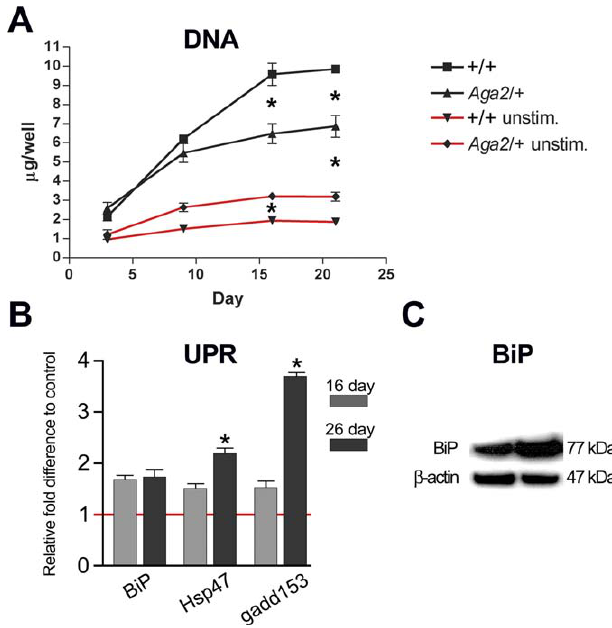
Figure 5. Anomalies in Aga2/ þ Osteoblast Growth and Induction of Cytoprotective Unfolded Protein Response (A) Growth curve analysis of þ / þ and Aga2 / þ primary calvarial culture system. (B) UPR, qPCR analysis of stimulated calvarial OBs. Values represent means 6 SEM, where n ¼ 4–5 experiments (* p , 0.01 Student t -test). (C) Western analysis of BiP using primary OBs.